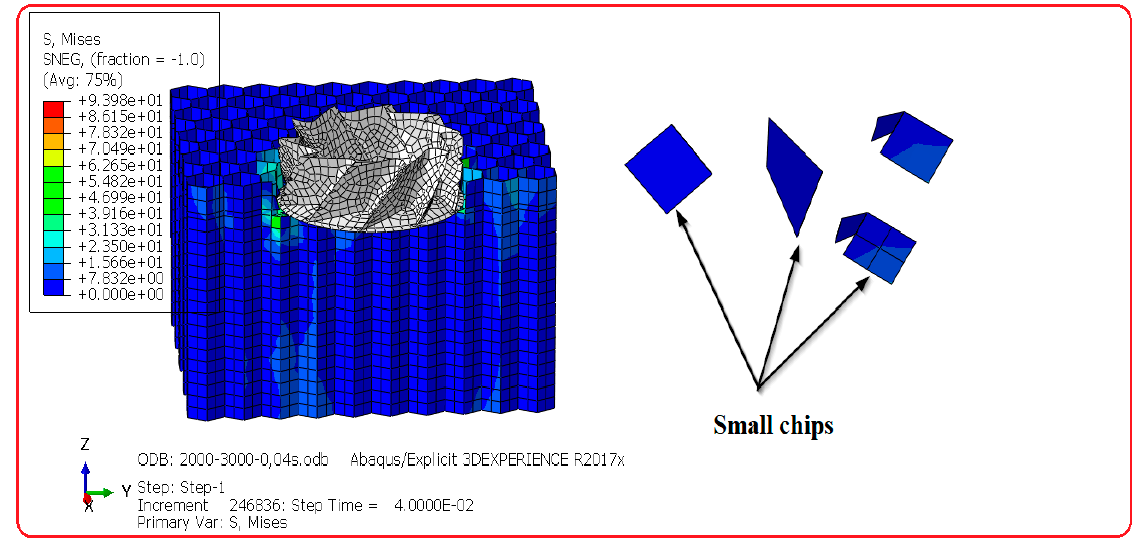
Figure 12. Resulting chip size by the diameter-cutting blade of 16.3 mm.